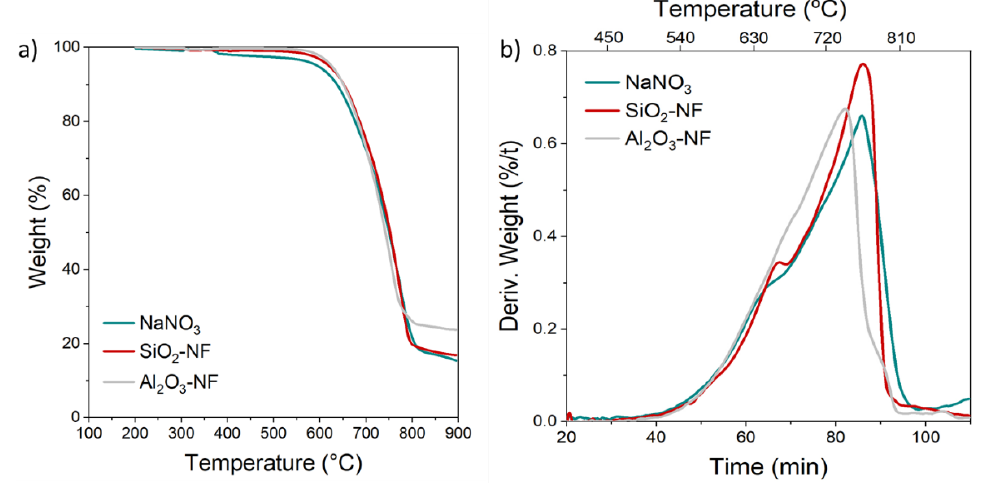
Figure 7. TGA measurement from 100 to 900 ◦ C of NaNO 3 , and NaNO 3 /SiO 2 , NaNO 3 /Al 2 O 3 NFs with 1% wt. of NPs: ( a ) weight loss as a function of temperature and, ( b ) weight derivative as a function of time and temperature.